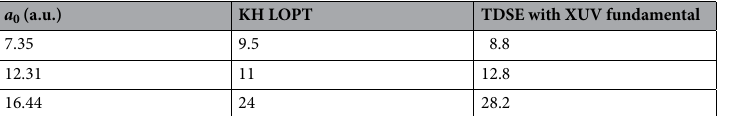
Table 1. ‘Internuclear distance’ R (a.u.) from KH LOPT and TDSE with XUV fundamental field